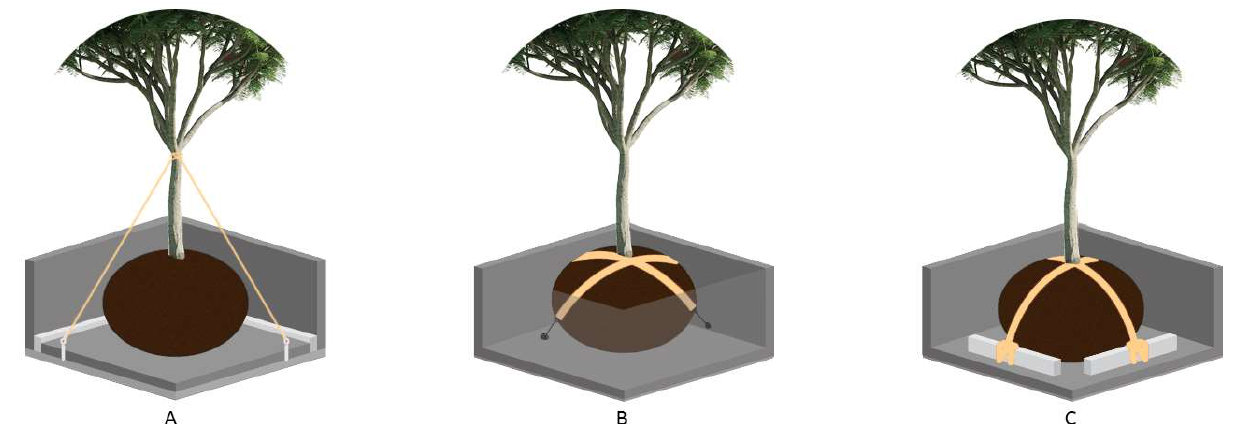
Figure 3. Different anchoring system types, illustrated based on the Melbourne guidelines [21]. ( A ) = plate anchorage system, ( B ) = rootball anchorage to planter wall, and ( C ) = anchor straps and ‘dead man’ system.